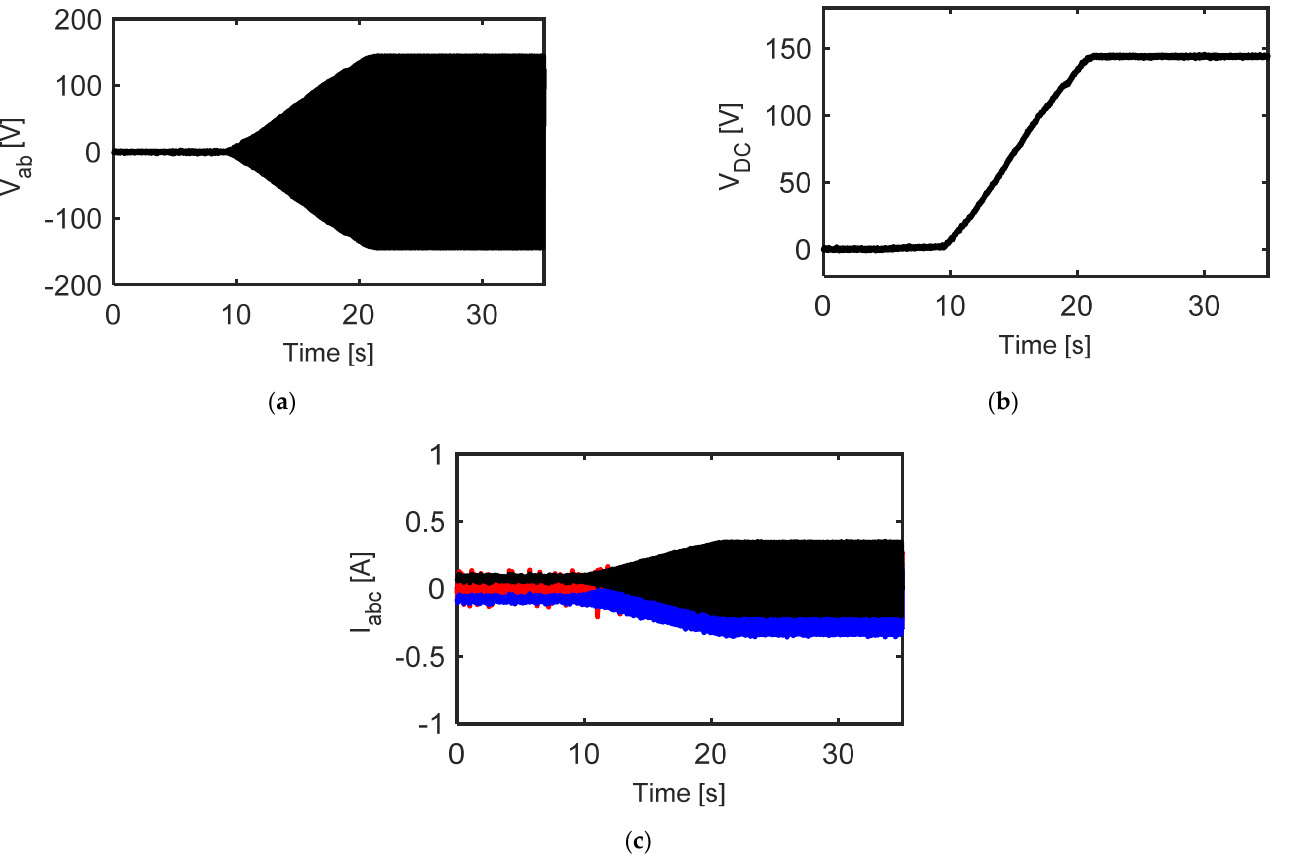
Figure 9. Experimental testing of the clamping circuit at start-up without operating the PWM of the rectifier and charging using ramp-line voltage V ab ( a ) Line-input voltage V ab , ( b ) DC-link voltage and ( c ) input current for